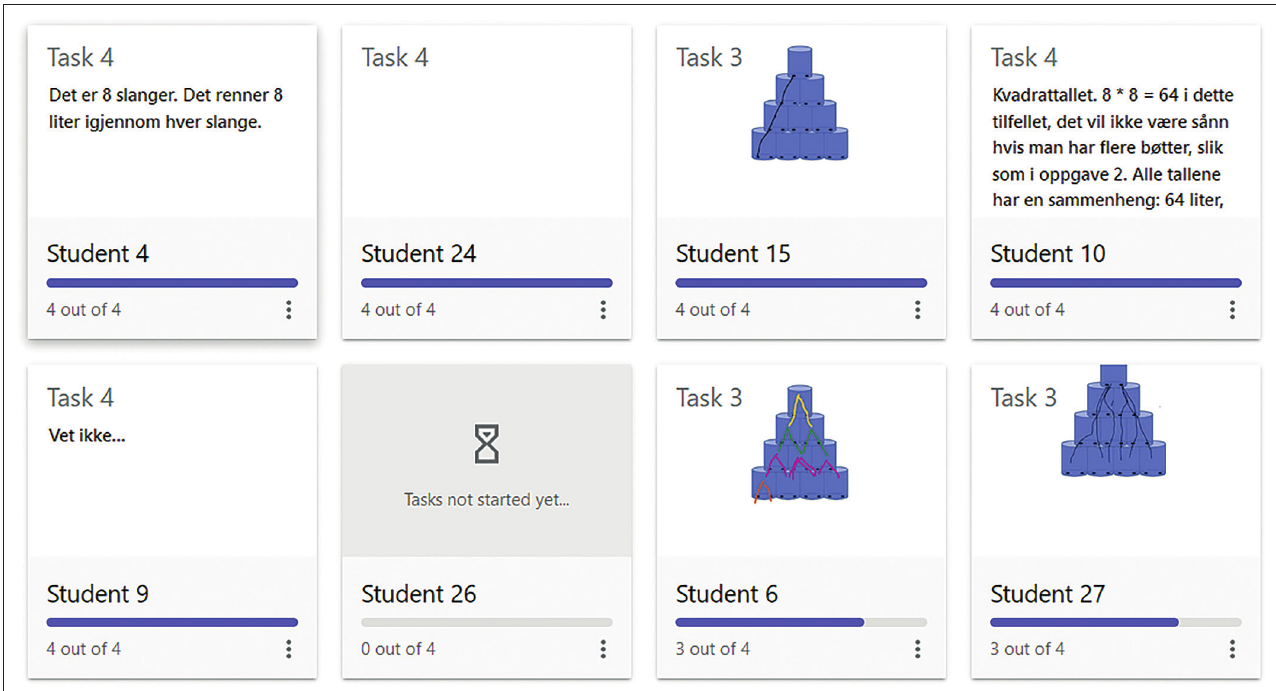
FIGURE 1-A1 (Continues ... ): Screenshot of the works of Students using the Class function in